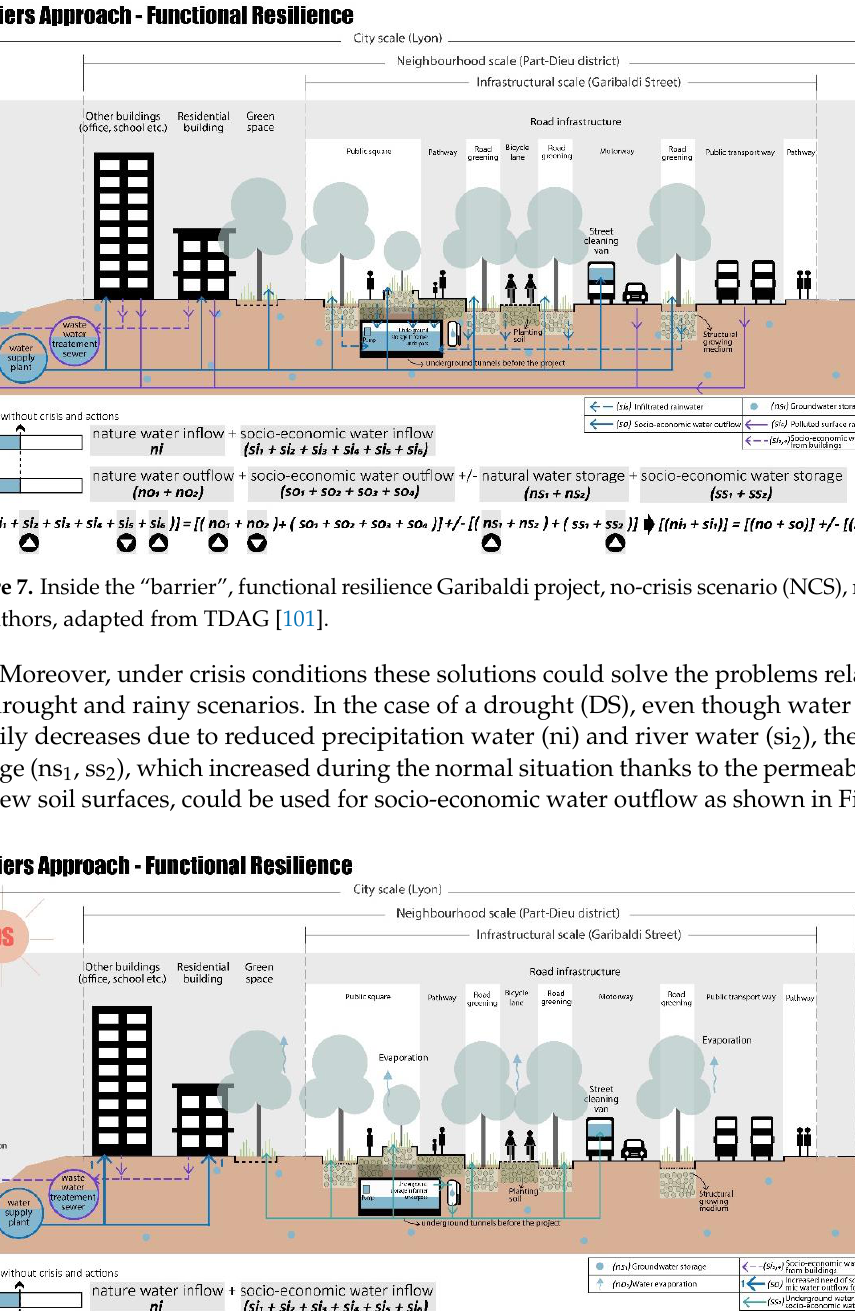
Figure 9. Inside the “barrier”, functional resilience rainy scenario, realised by authors, adapted from TDAG [101]. 4.2.2. Behind the Barriers Approach — Correlative and Territorial Resilience Following the BB theory, going “ Behind the B arriers” means going behind the spa- tial – temporal barriers of the study system to achieve the water balance in the Part-Dieu neighbourhood and without considering the retrofit project of Rue Garibaldi.